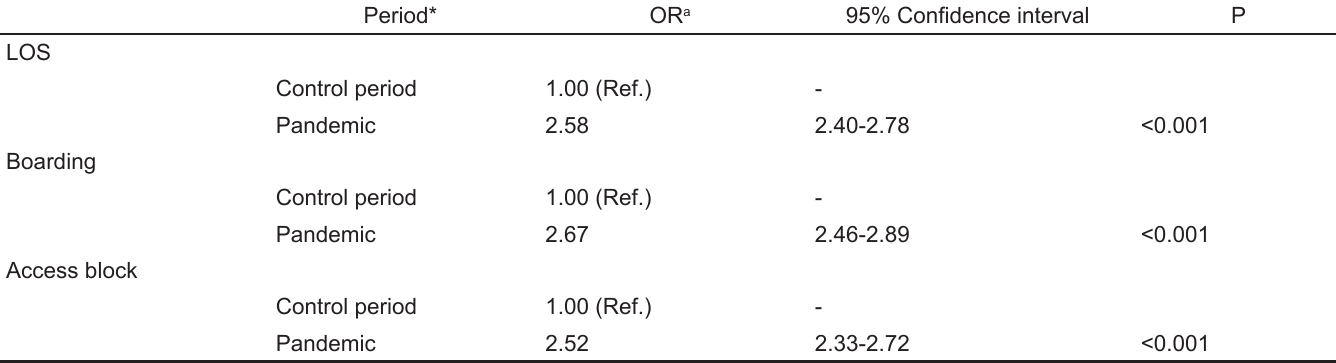
Table 5. Risk of overtime for selected time variables accounting for crowding, by period.